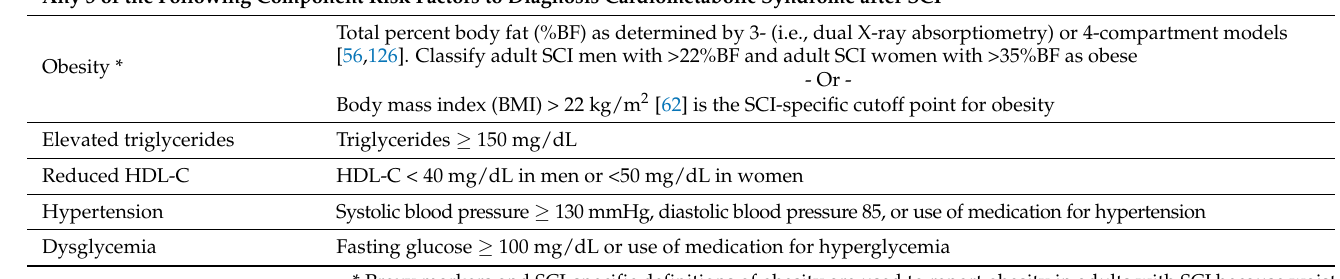
Table 5. Guideline Definition for Cardiometabolic Syndrome for Adults with Spinal Cord Injury from the Paralyzed Veterans of American Consortium for Spinal Cord Medicine Clinical Practice Guidelines on Identification and Management of Cardiometabolic Risk after Spinal Cord Injury